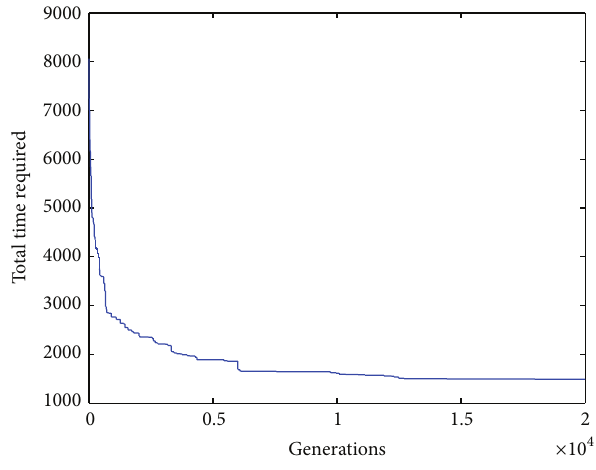
Figure 6: The convergence curve for workpiece 3.